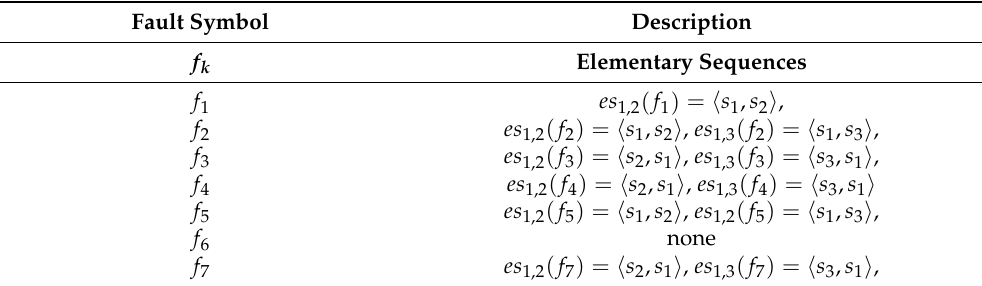
Table 8. Elementary sequences for an object.